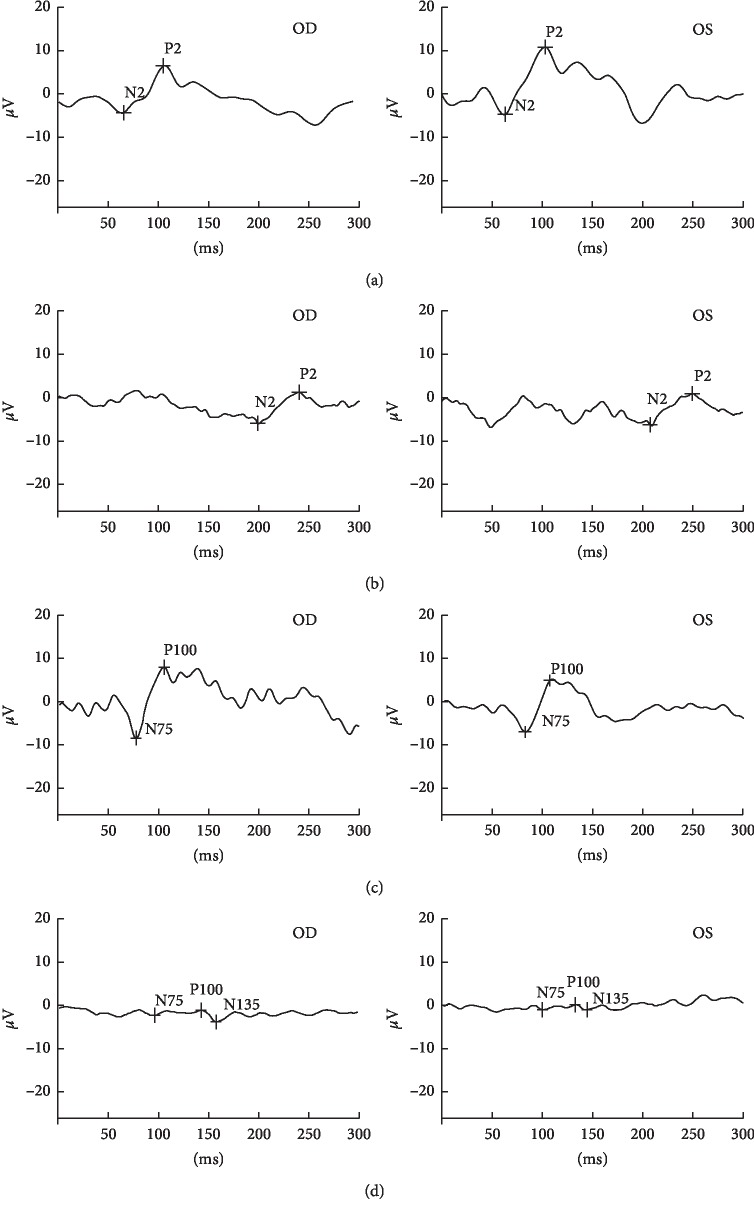
VEP test results of four members in the DOA family, and F-VEP tests were presented. (a) An unaffected family member III-5 showing a normal bilateral F-VEP pattern. (b) A DOA patient IV-5 showing prolonged P-wave latencies and severe lower P-wave amplitudes in both eyes. (c) P-VEP tests were presented in an unaffected family member IV-1, showing a general normal bilateral P-VEP pattern. (d). A DOA patient IV-3 showing a severe P100 amplitude reduction in both eyes.